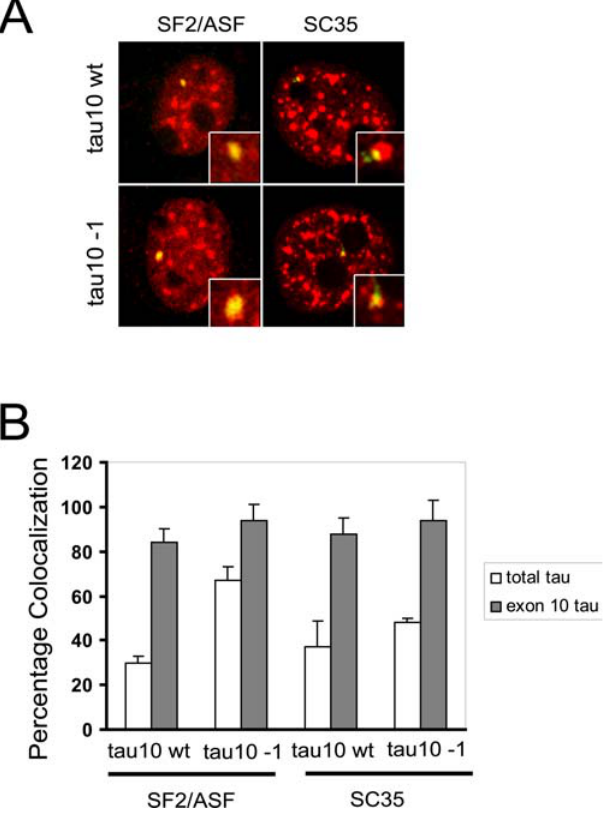
Figure 4. Mutation-Independent Differential Recruitment of Endogenous Pre-RNA Splicing Factors (A) Stable cell lines expressing minigenes containing a G . A mutation at þ 3 (tau10 þ 3) or a C . U mutation at þ 14 (tau10 þ 14). Both mutations give preferential inclusion of exon 10 as previously reported for transient expression. (B) Quantitative real-time PCR analysis demonstrating the preferential inclusion of exon 10 in tau10 þ 3 and tau10 þ 14 compared to tau10wt. Values represent averages 6 standard deviations from at least three experiments. Values of included exon 10 are normalized to total minigene RNA. (C) Quantitative analysis of recruitment of endogenous splicing factors to tau10 þ 3 or tau10 þ 14. Recruitment of splicing factors to tau transcription sites detected by combined RNA-FISH using specific probes against the tau minigene and IF microscopy with specific anti-splicing factor antibodies. Percentage of cells with colocalization of tau RNA-FISH and splicing factor signals is indicated. Values represent averages from at least 100 transcription sites from three experiments 6 SEM. DOI: